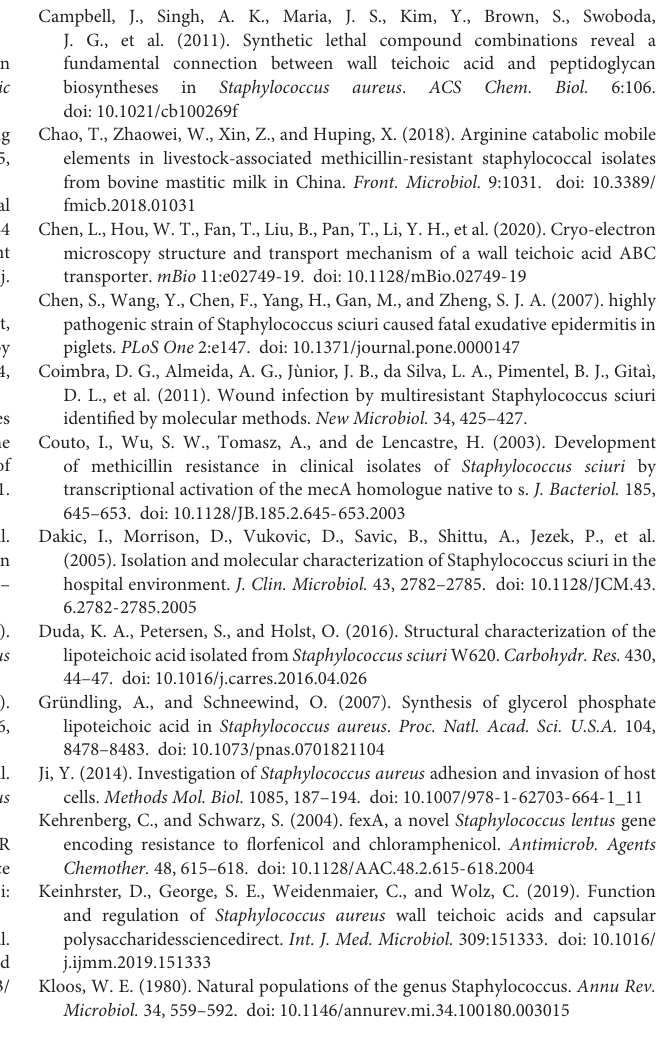
Supplementary Figure 1 | A survey of antibiotic-resistance genes of Nwaf26. A total of 35 genes in Nwaf26 were highly similar (more than 40%) to the reference gene sequence of the Card Database. Supplementary Figure 2 | Correlation analysis of Rna-seq data and qRt-Pcr results. The correlation index was 0.94, indicating that transcriptome data were